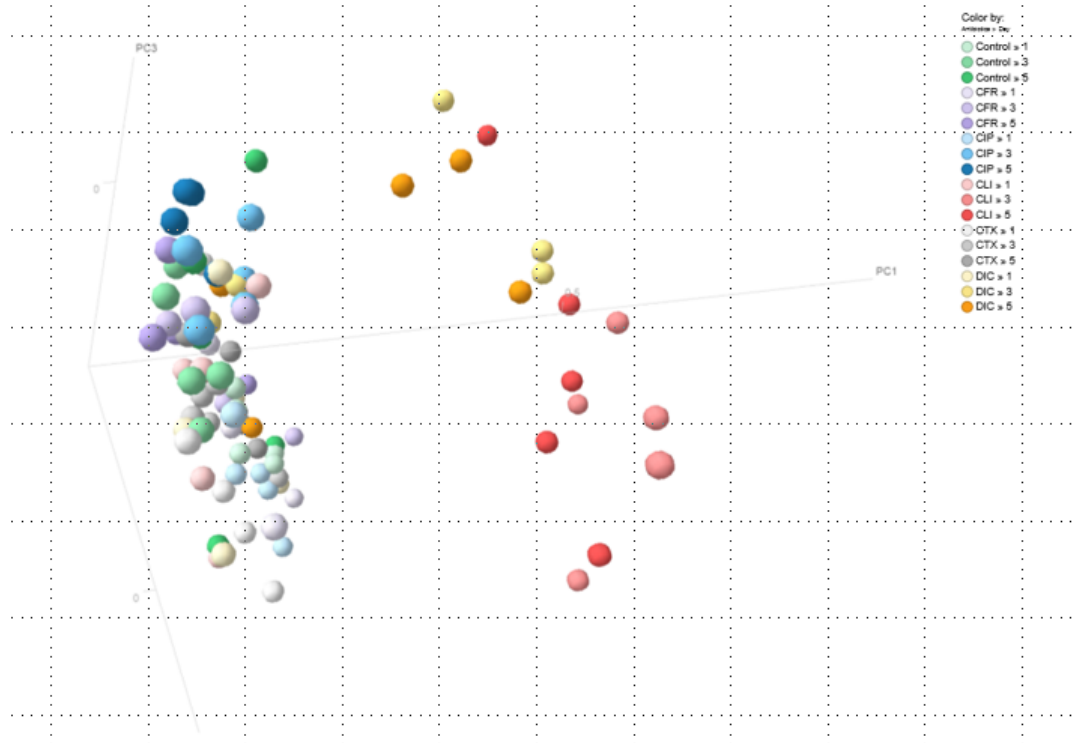
Figure 3. The principal coordinates analysis (PCoA) based on cosine distance between samples from all mice on all days. Each dot represents a gut microbiota profile. Colours show the antibiotic group and day. The further dots are separated, the larger the dissimilarity between associated gut microbiota profiles. The group to the right ( red and orange ) represent individual profiles from mice in the clindamycin and dicloxacillin groups at days 3 and 5. These are clearly separated from the rest of the samples. PCoA starts by putting the first point at the origin, and the second along the first axis (e.g., PC1). Each axis can represent a phylum or bacterial species. Further points can be added, which usually means adding a second axis followed by a possible third axis and so forth (e.g., PC2 and PC3 etc.). A successful PCoA will, therefore, generate a 2–3 axes. Each object has a 'score' along each axis. The combined scores delivering the position in the plot. Via PCoA, we visualize the dissimilarities, or distances, between samples from mice receiving antibiotics. Interpretation of a PCoA plot is straightforward: Objects closer to one another are more similar than those further away. The points illustrate the normal variation for controls and the variation induced by antibiotic treatment. Antibiotic treatments were given once a day for three days (day 1 to day 3). The faeces was collected on day 1 (prior to the antibiotic treatment), on day 3, and finally on day 5 (two days after the end of treatment), respectively. “1” = Day 1, “2” = Day 2, and “5” = Day 5. Control : No antibiotics